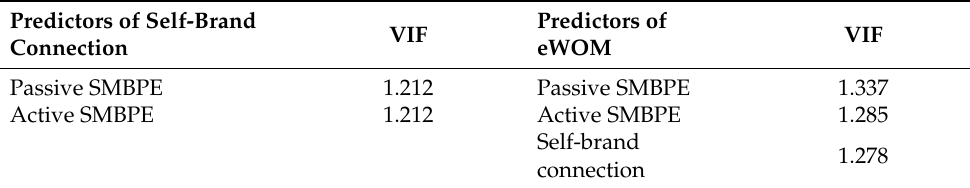
Table 3. Collinearity assessment.